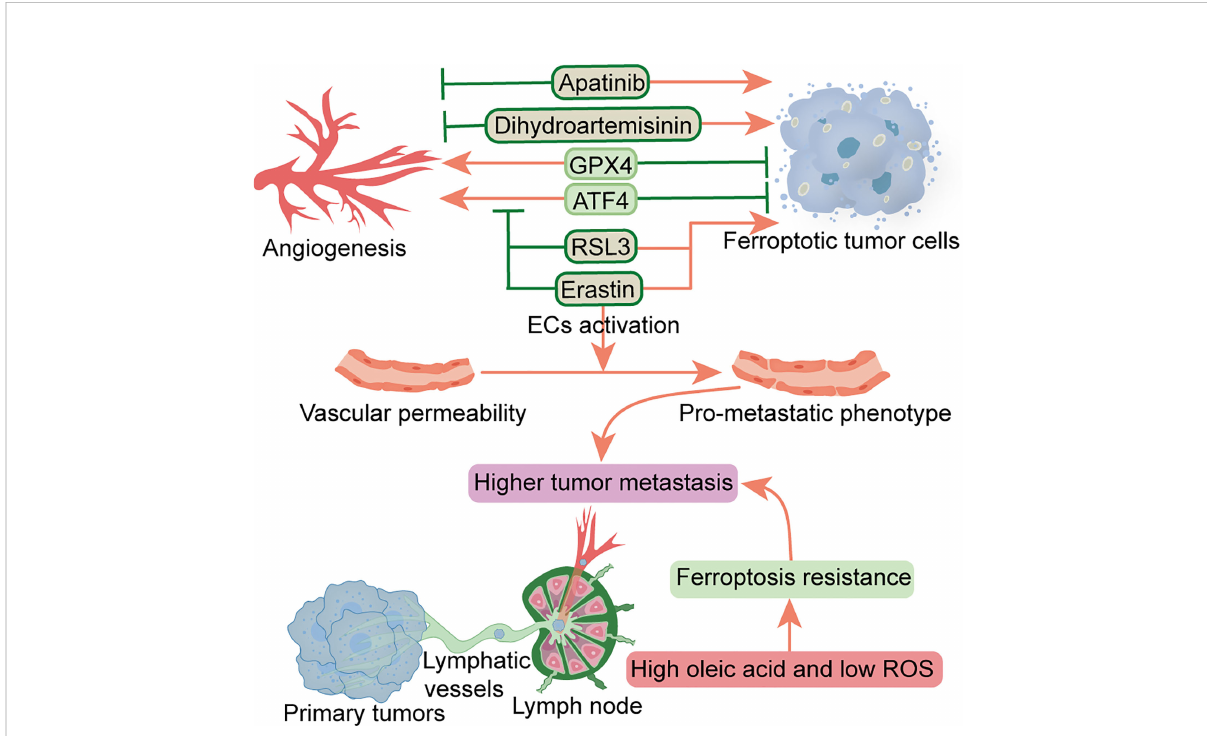
FIGURE 2 Relationship between ferroptosis and angiogenesis and vascular permeability and lymphangiogenesis. Factors that inhibit angiogenesis and promote ferroptosis include RSL3, erastin, dihydroartemisinin and apatinib. Erastin can also promote vascular permeability. ATF4 and GPX4 can promote angiogenesis and inhibit ferroptosis. Metastatic tumor cells escape ferroptosis through lymphatic vessels in low ROS and high oleic acid lymph node microenvironment. ATF4, transcription factor 4; ECs, endothelial cells; GPX4, glutathione peroxidase 4; ROS, reactive oxygen